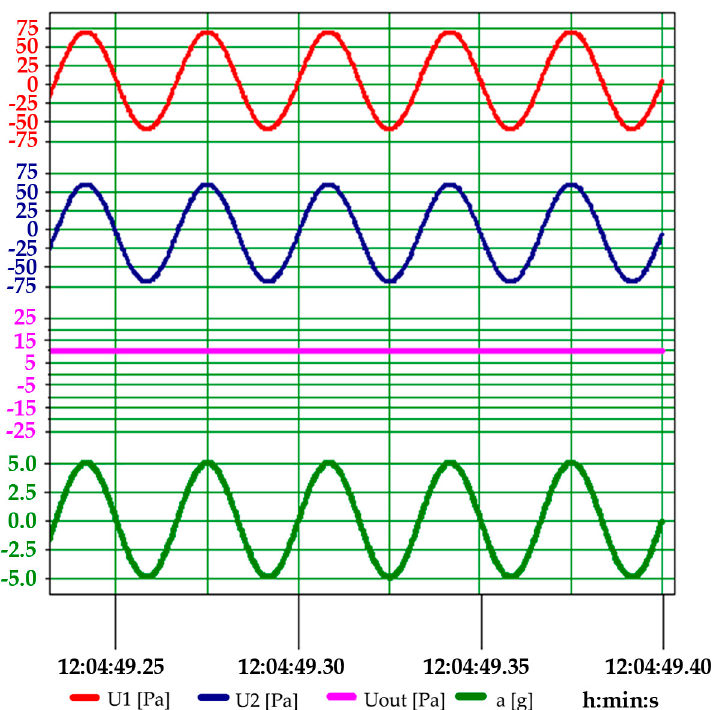
Figure 16. Waveforms of the experimental values of acceleration (a), pressure (p), and output signals (U 1 ; U 2 ; U out ) for dynamic acceleration with vibrations and with an amplitude of 1 g, frequency of f = 30 Hz, and pressure excitation of p = 5 Pa for the double-membrane transducer.